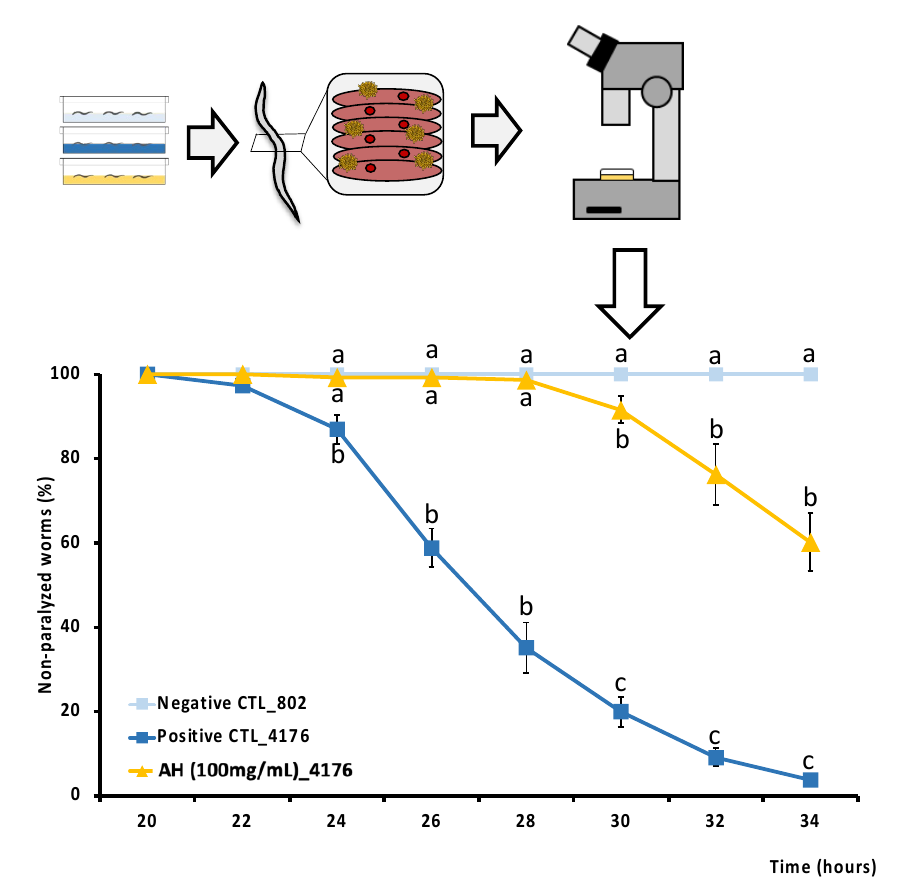
Figure 5. Schematic and analytical representation of the cytoprotective analysis of AH against amyloid- β -induced toxicity in C. elegans . Results are mean ± SEM. For each time, different lowercase letters means statistically significant differences between experimental groups ( p <